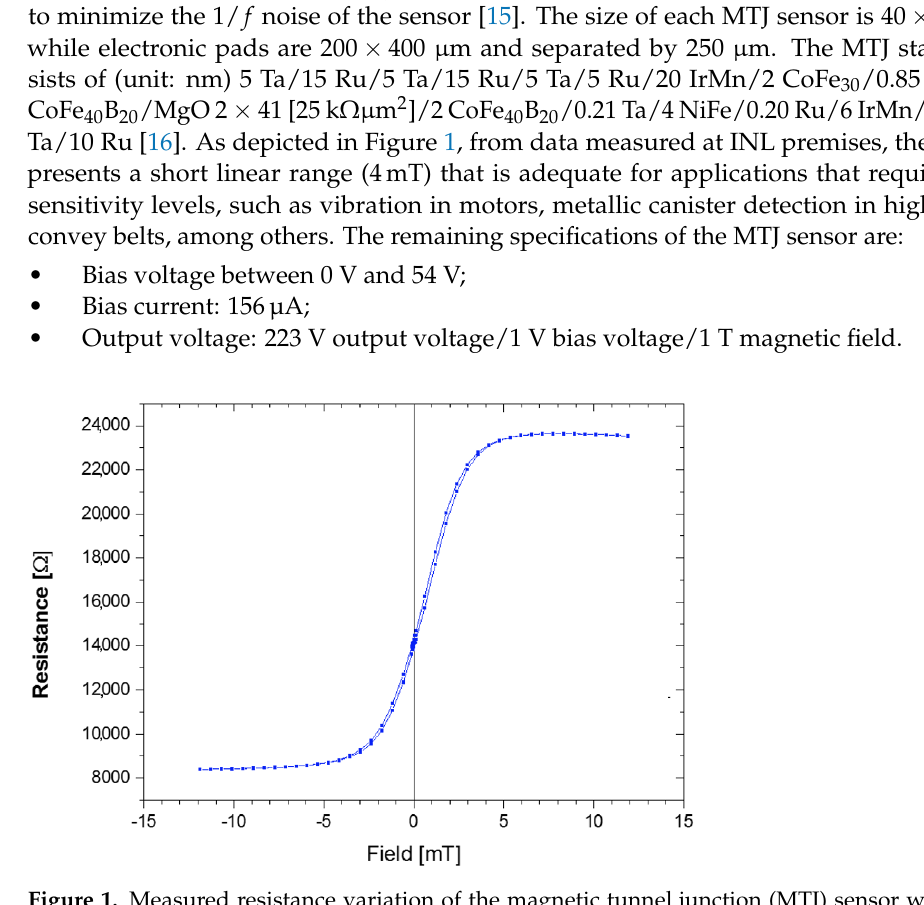
Figure 1. Measured resistance variation of the magnetic tunnel junction (MTJ) sensor with mag- netic